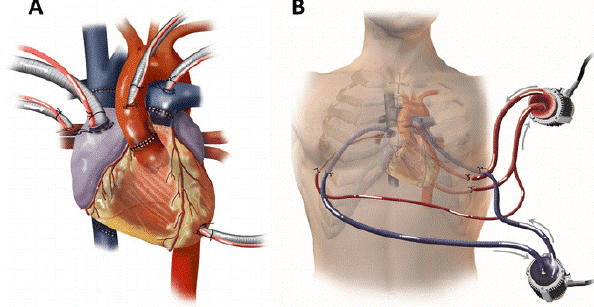
Fig. 1 - CentriMag®. A) Cannulation strategy: a CentriMag® was used to support the left heart with cannulation via the left atrium, left ventricle, and aorta. Another CentriMag® was used to support the right ventricle with cannulation via the right atrium and pulmonary artery. This strategy allowed for excellent flows from both devices and complete decompression of the heart. B) CentriMag® access strategy: all cannulas were removed from the chest through intercostal or subcostal incisions, allowing sternotomy closure.